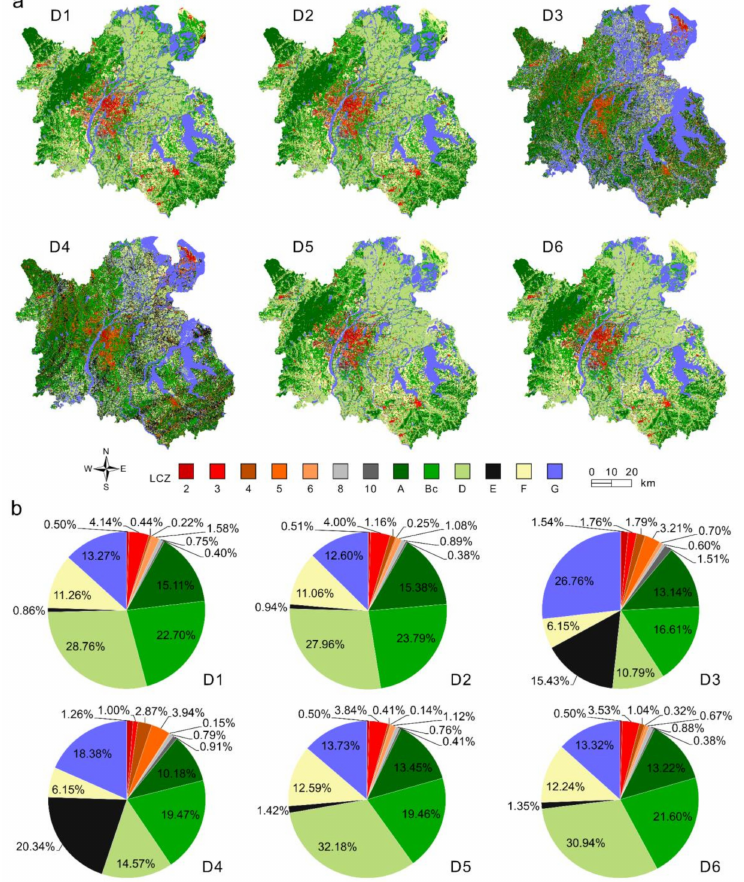
Figure 3. ( a ) LCZ maps obtained with each of the six datasets ( D1 – D6 ); ( b ) percentages of LCZ classes with each of the six datasets ( D1 – D6